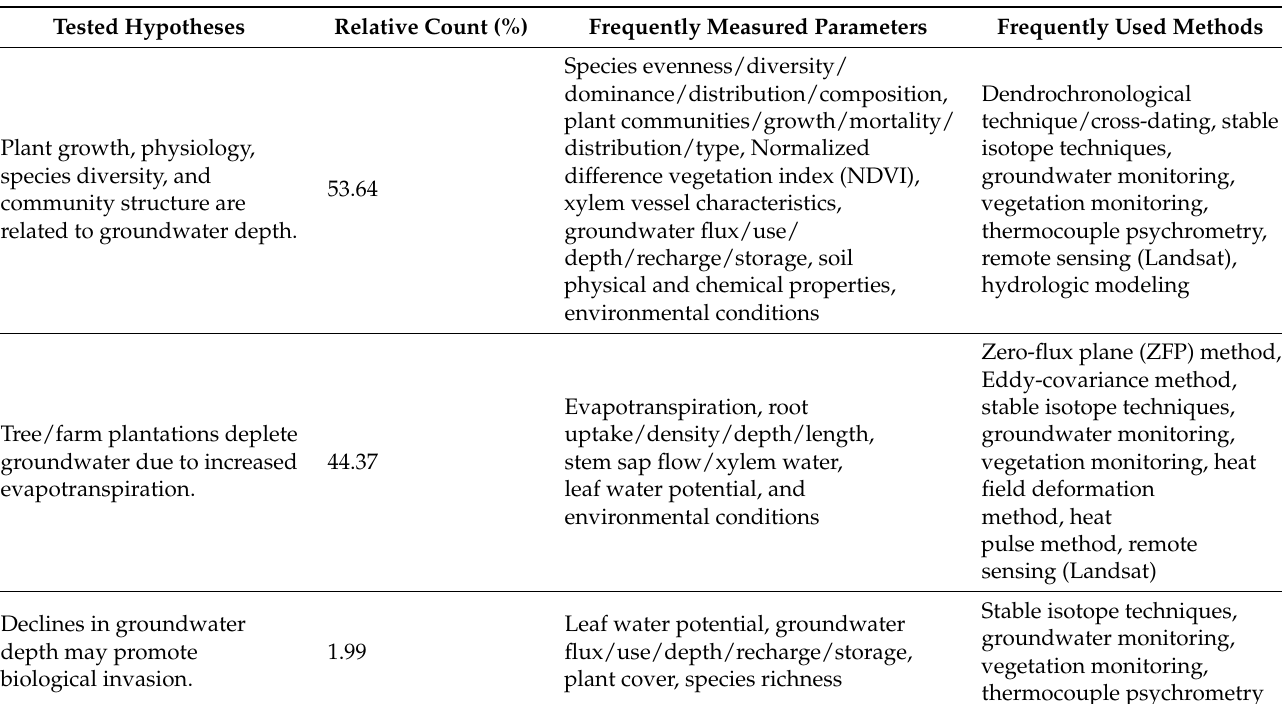
Table 3. Research topics, parameters, and methods based on the frequently tested hypotheses about groundwater–vegetation